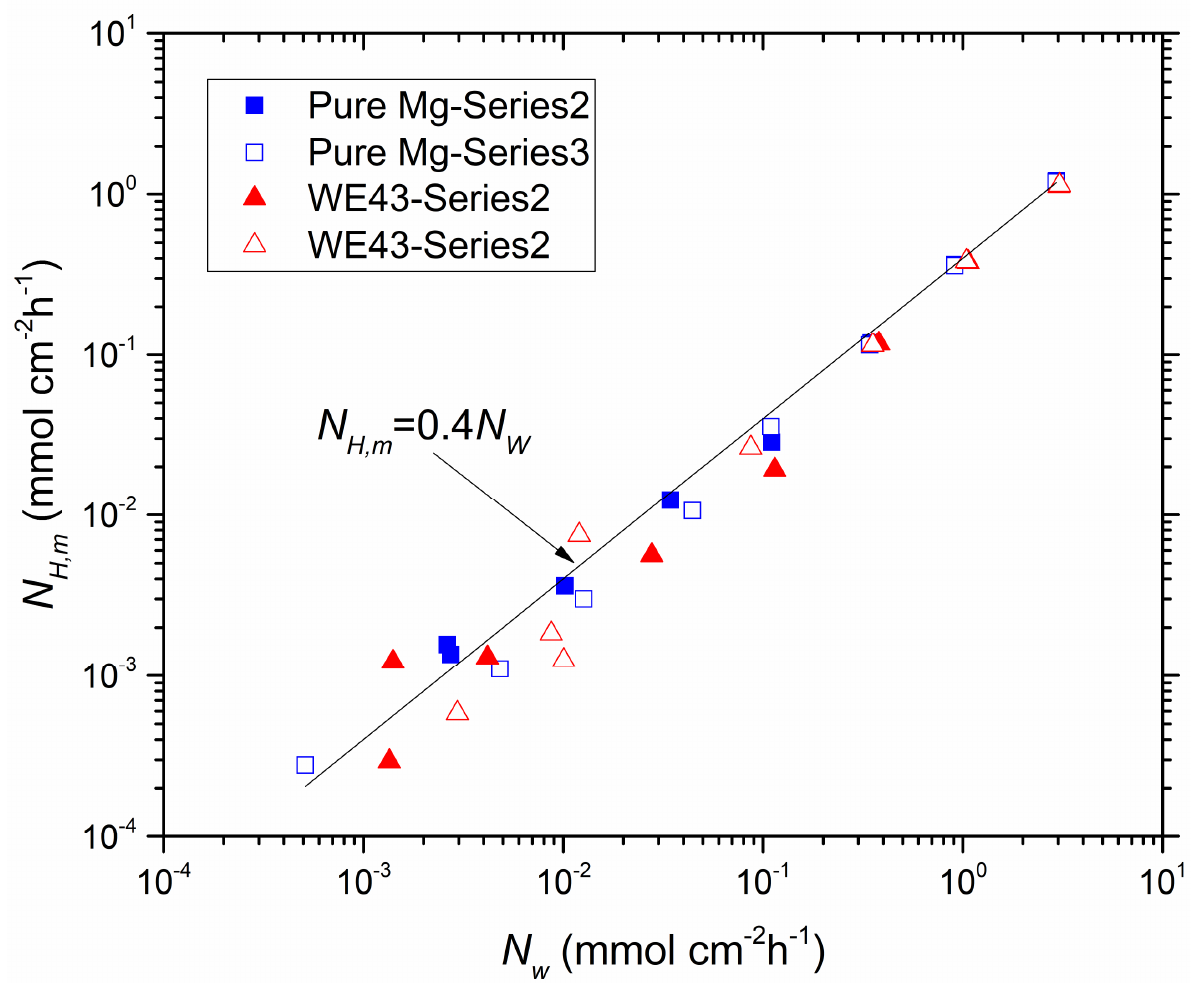
Figure 17. Plot of N H against N W from the experimental data of Li et al. [92]. The experimental data points are presented. The line drawn is that predicted by Equation (13) and is not a line of best fit through the data. Nevertheless, the line predicted by Equation (13) is a good fit through the experi- mental data providing further experimental validation for the uni-positive Mg + corrosion mecha- nism.